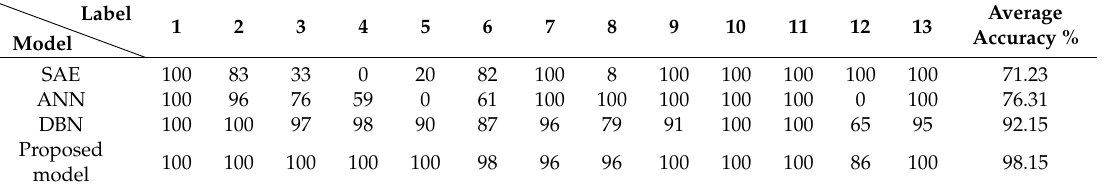
Table 5. Comparison of testing results of dataset1 under load 0 kN by di ff erent models.